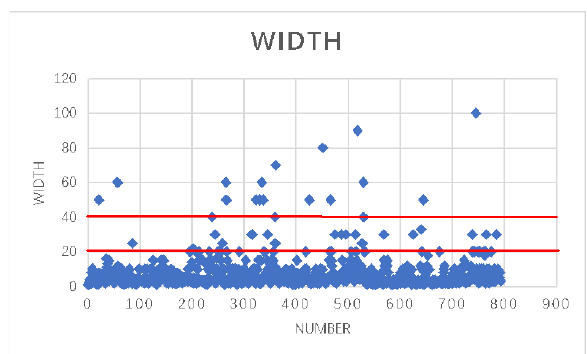
Figure 15. The three section of the cracks’ width.